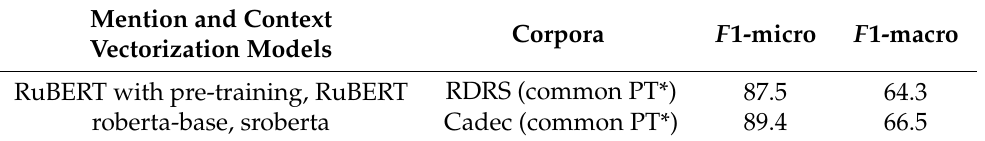
Table 6. Comparison of the accuracy of normalization on RDRS and CADEC corpora, * common